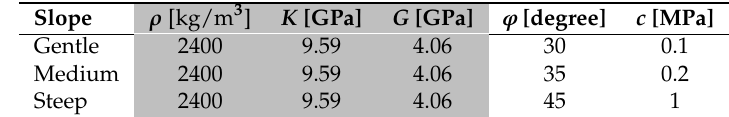
Table 3. Elastic properties of the block material ( ρ —density; K —bulk modulus; G -shear modulus; ϕ —internal friction angle; c —internal cohesion).